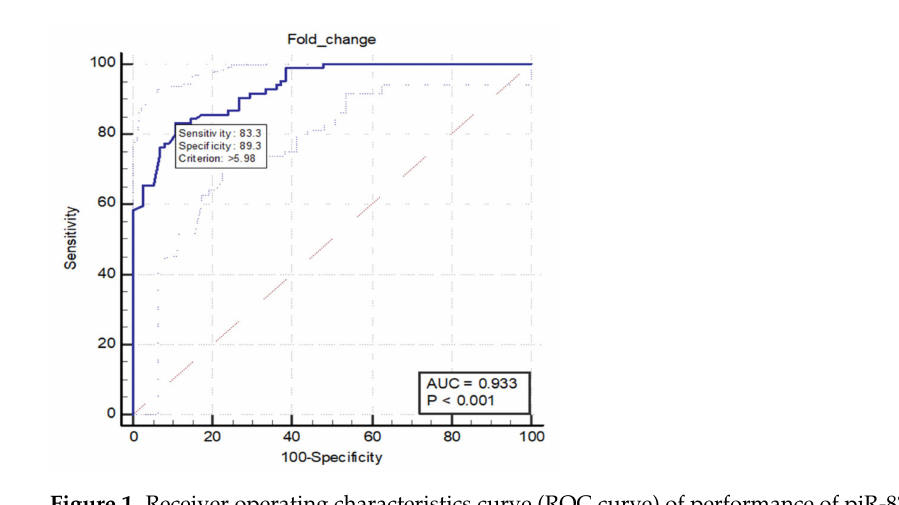
Figure 1. Receiver operating characteristics curve (ROC curve) of performance of piR-823 in diagnos- ing patients with colorectal carcinoma. The test shows 83.3% sensitivity and 89.3% specificity at a cut-off value of >5.98-fold change, with an area under the curve of 0.933 ( p < 0.0001).